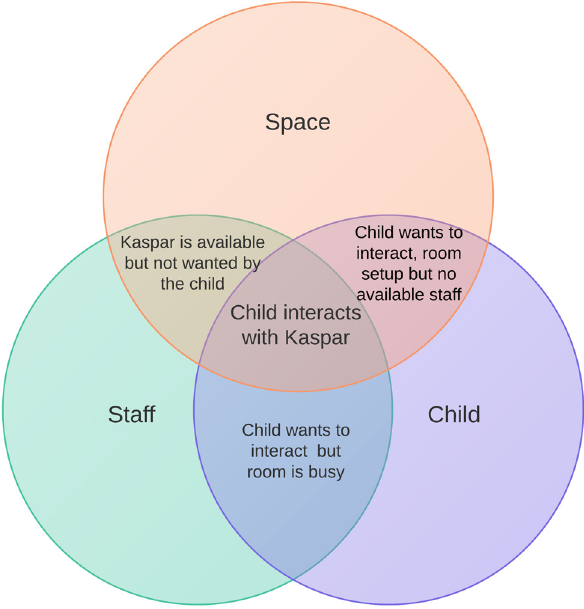
Figure 10: Venn diagram for use of